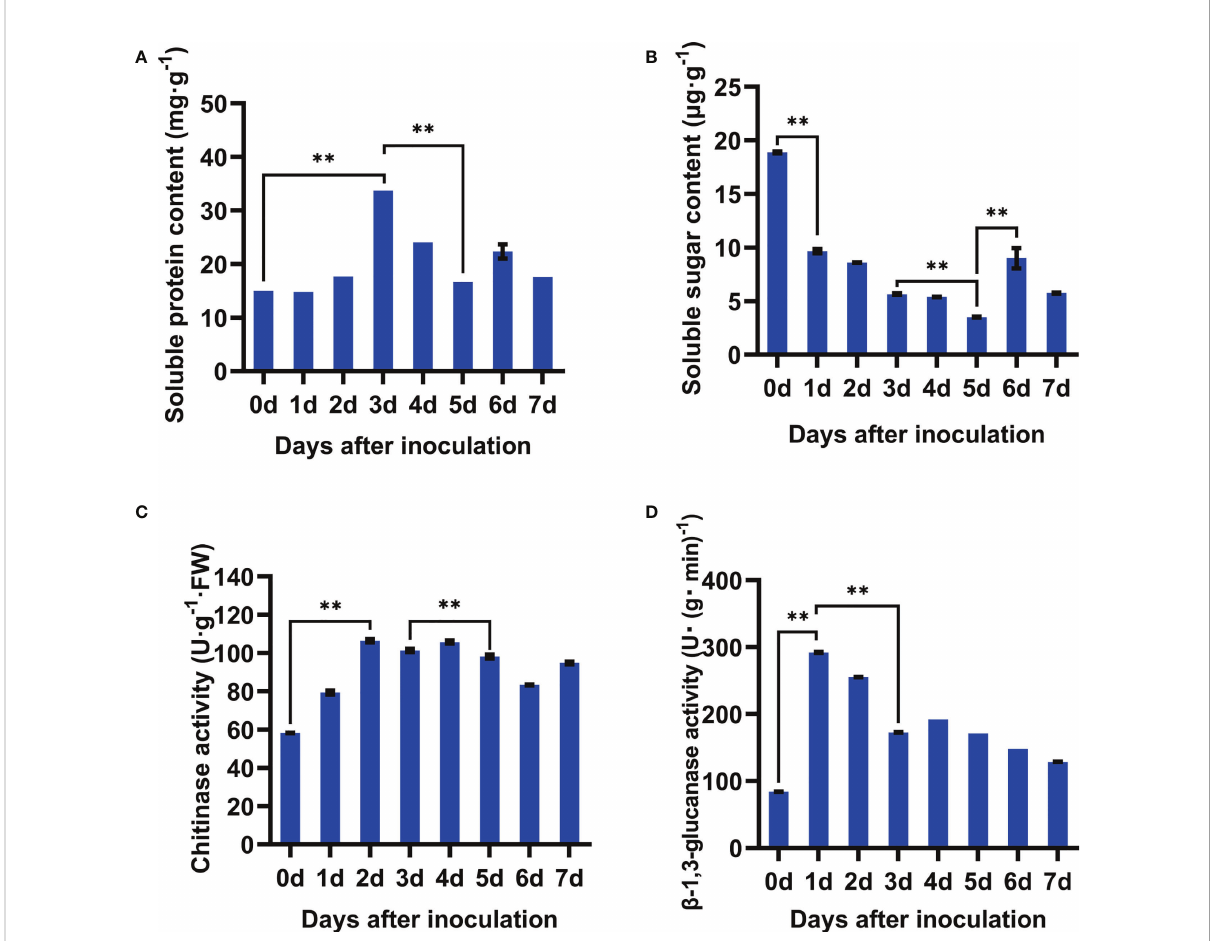
FIGURE 2 Determination of physiological and chemical characteristics of soybean seeds after inoculation with F. fujikuroi . (A) Soluble protein content. (B) Soluble sugar content. (C) Activity assay of chitinase. (D) Activity assay of b -1,3-glucan. Each treatment contains fi ve plates with 10 seeds on each plate (n = 50), and three independent experiments were conducted. Statistical analysis was conducted using SPSS with the ANOVA method, and ** indicates signi fi cant difference at the level of